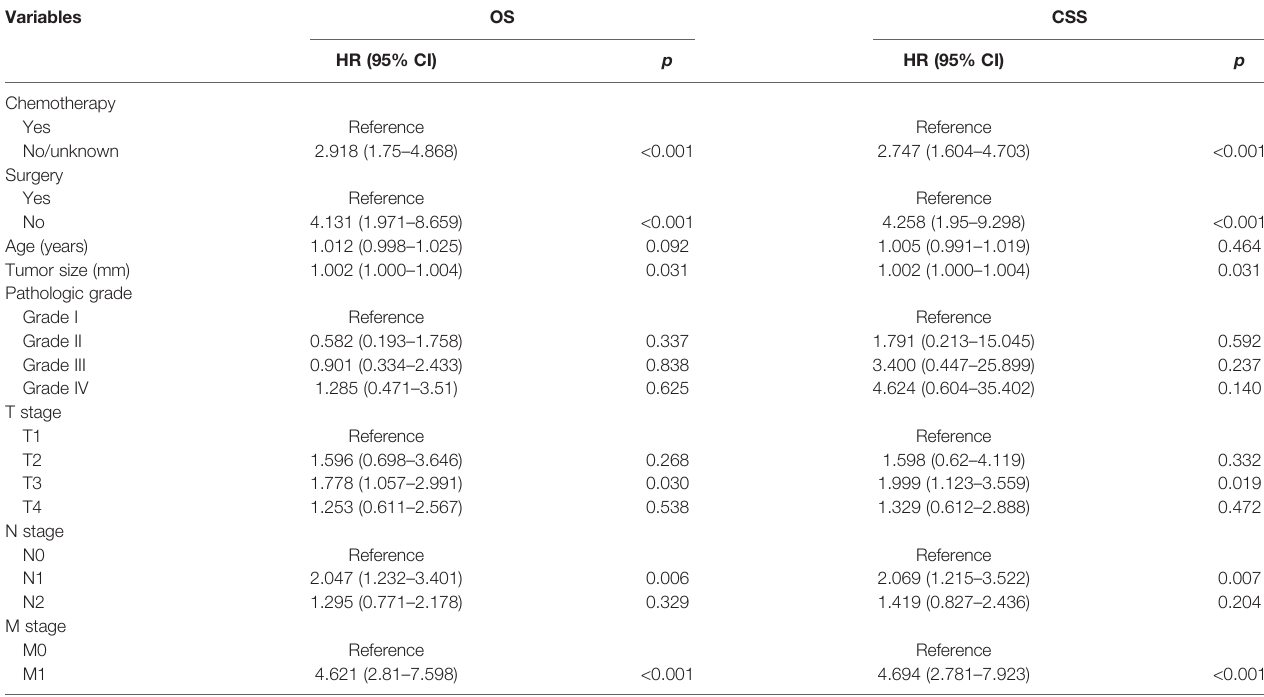
TABLE 4 | DAG-guided multivariable Cox regression model analysis of causal effect of chemotherapy on OS and CSS. Variables